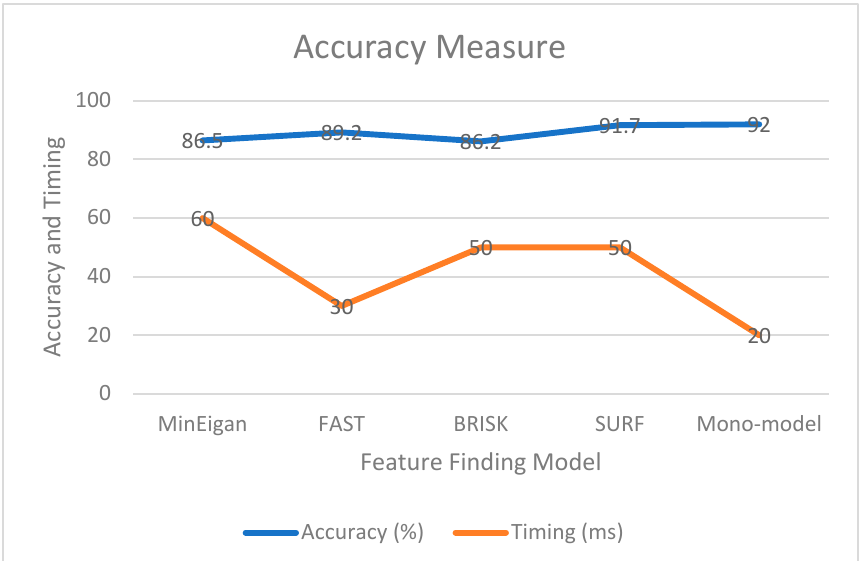
Figure 12. Accuracy Measure for feature identification.